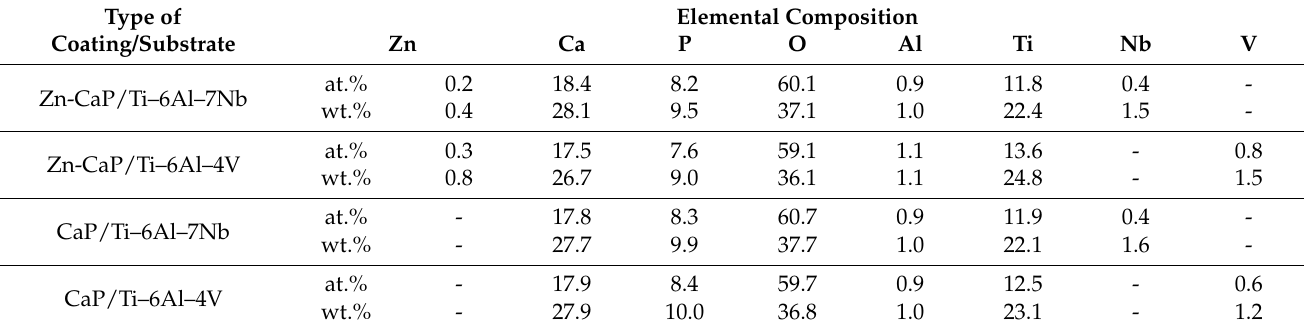
Table 3. Elemental composition of Zn-CaP and CaP coatings on Ti-based substrates according to EDX measurement. Type